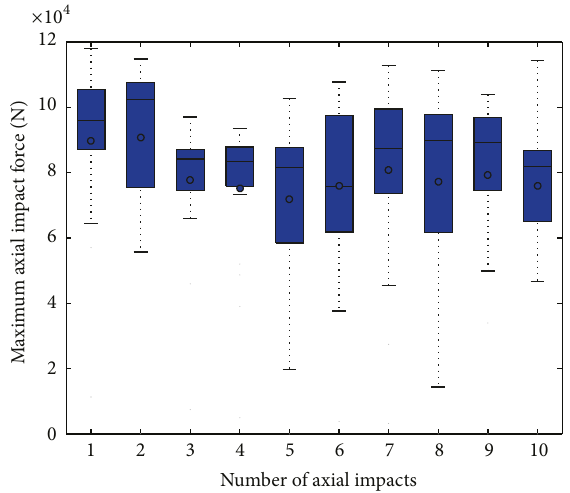
Figure 7: Estimated axial force. All 21 experiments.